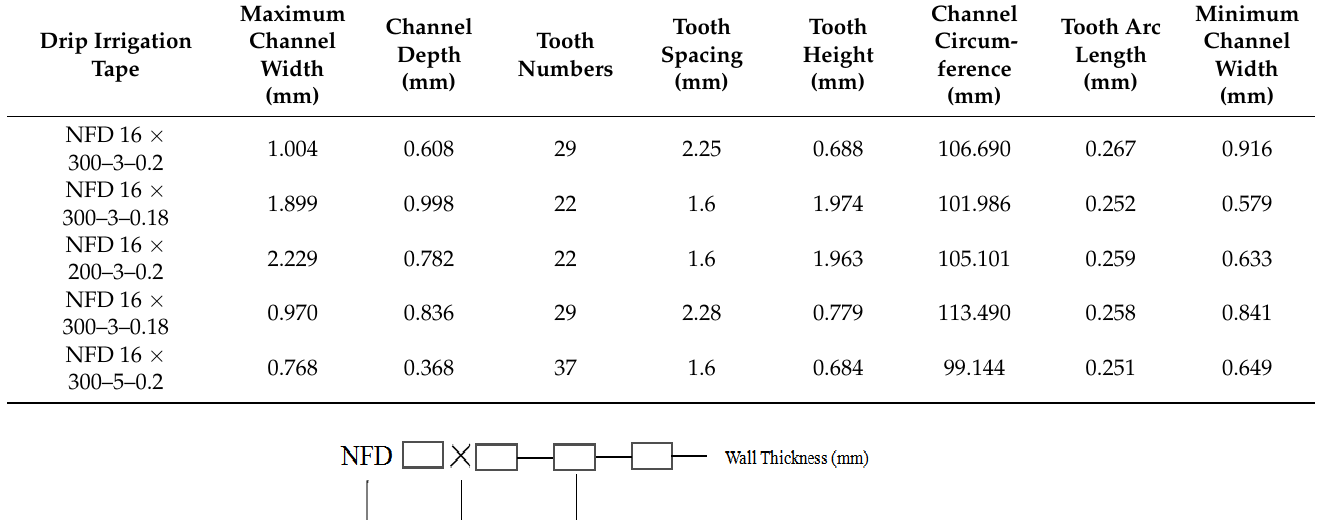
Figure 2. Schematic diagram of the hydraulic performance test setup and its connections.